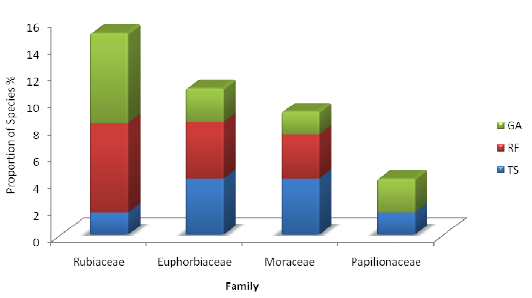
Fig. 4. Dominance of the top five families based on species richness in the respective forest sites